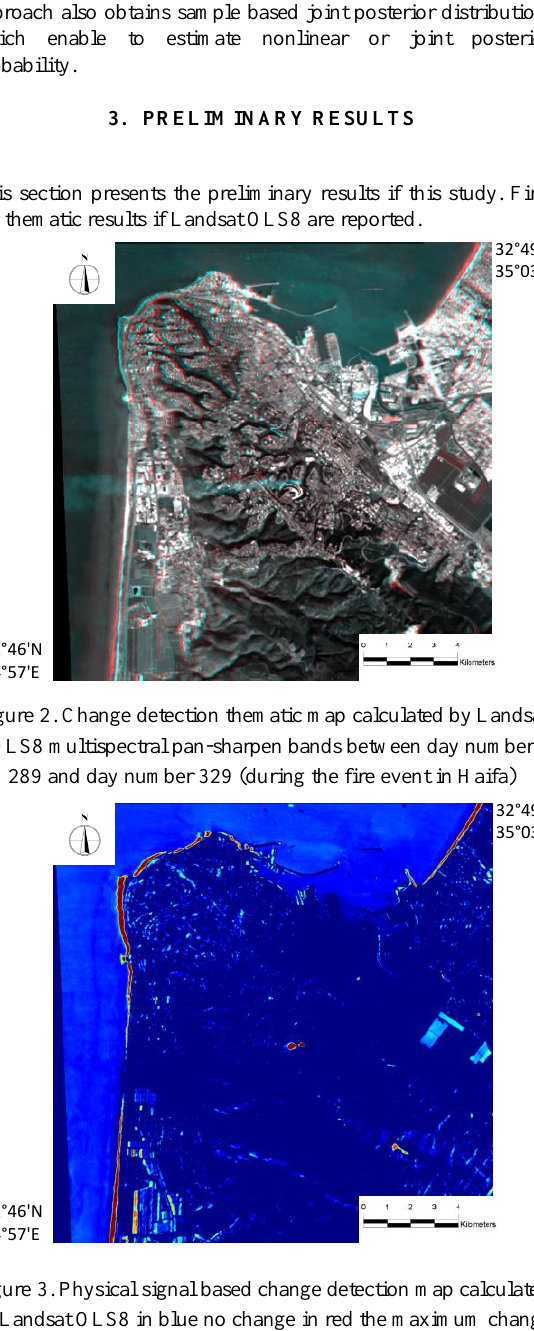
15 ˚ C Figure 6. Surface temperature calculated Landsat OLS8 thermal